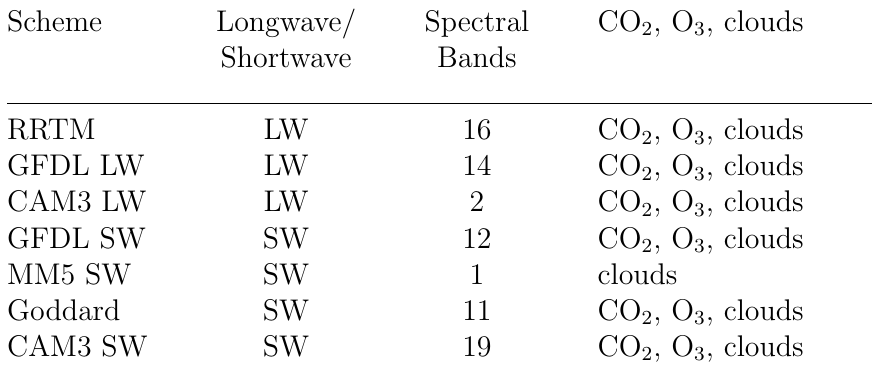
Table 8.5: Radiation